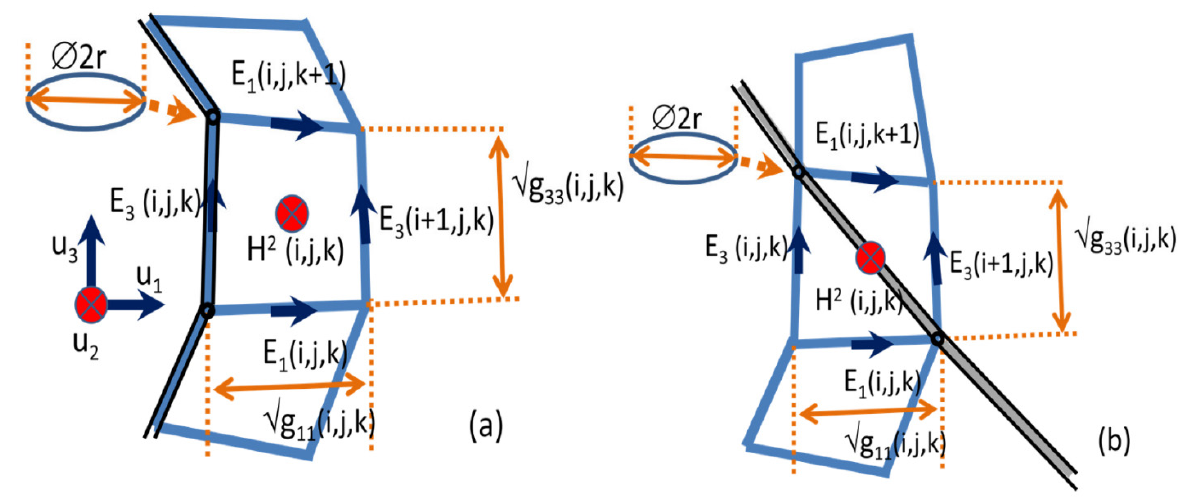
Figure 3. ( a ) Thin wire along the covariant field. ( b ) Thin wire oblique to covariant field. The substitution of the above field dependence in the Maxwell’s curl equations produces the following expressions,